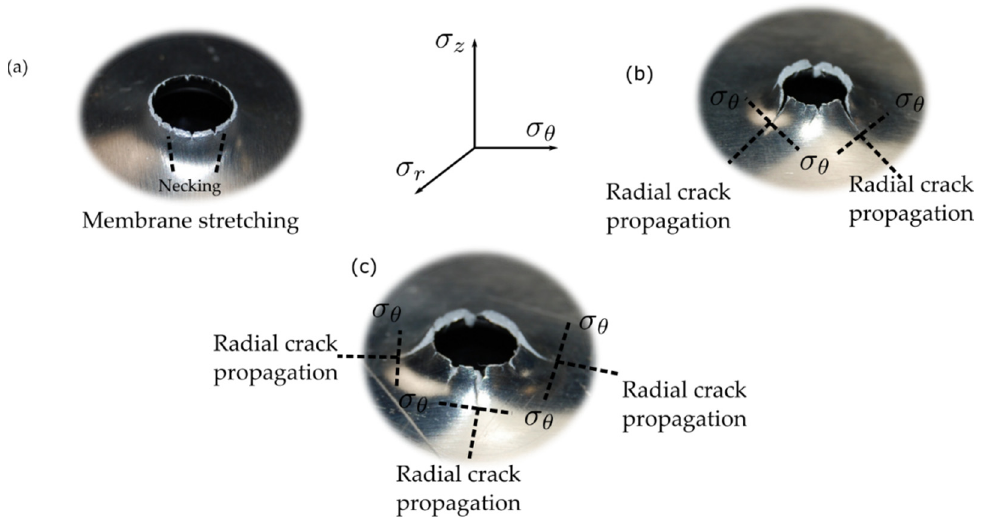
Figure 12. Experimental results: spherical steel projectile configuration. The final stage of the impact process for: ( a ) AA 6082 ‐ T6; ( b ) AA 5754 ‐ H111; ( c ) AA2024 ‐ T351.